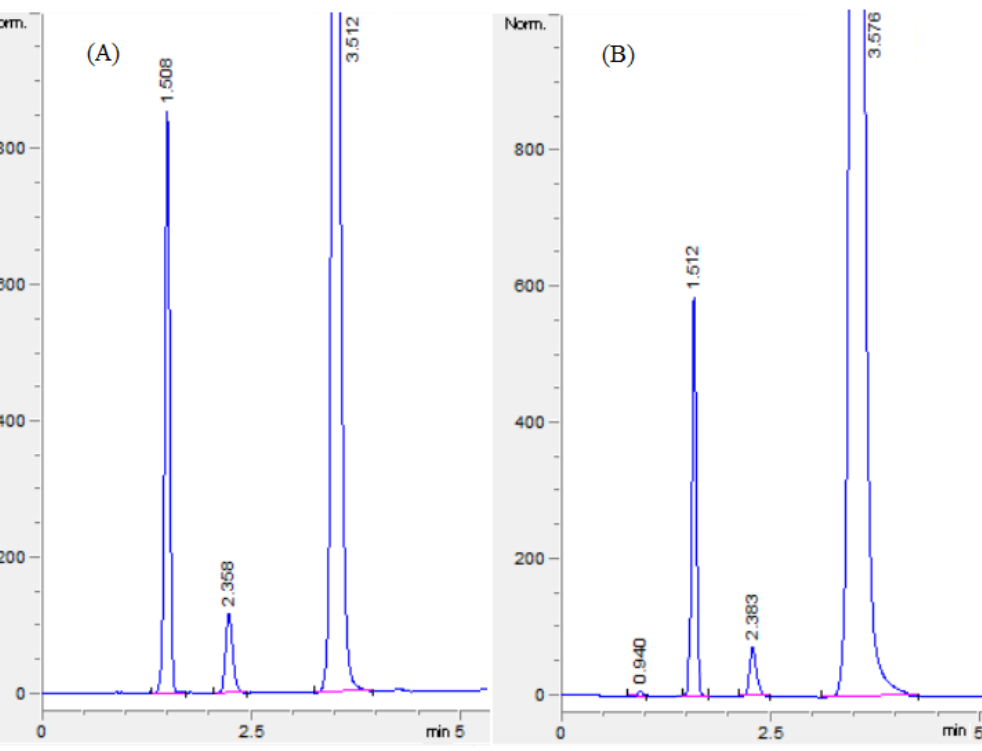
Figure 6. Representative chromatograms of standard solution ( A ) and formulation solution ( B ). Retention times: RE = 1.5 min, VD 2.3 = min, and MF = 3.5 min.